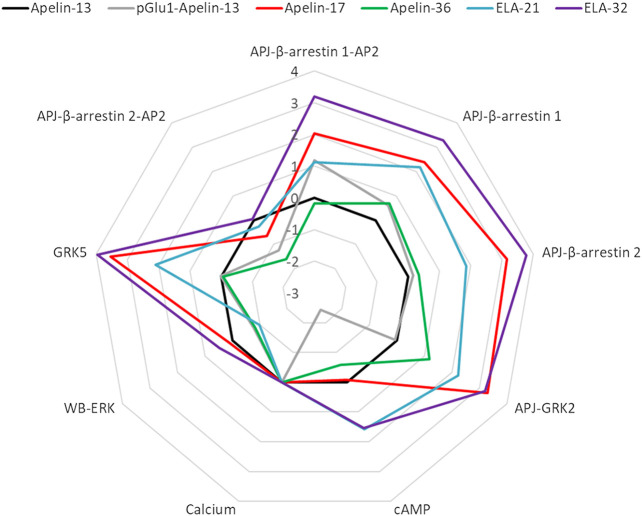
Web chart of Log (bias factor) of the six peptide ligands on eight pathways. Web of bias illustrating distinctions in the pattern of signaling of six peptide ligands at APJ. The web of bias plots ΔΔlog (τ/KA) values for each ligand and for every signaling pathway tested.